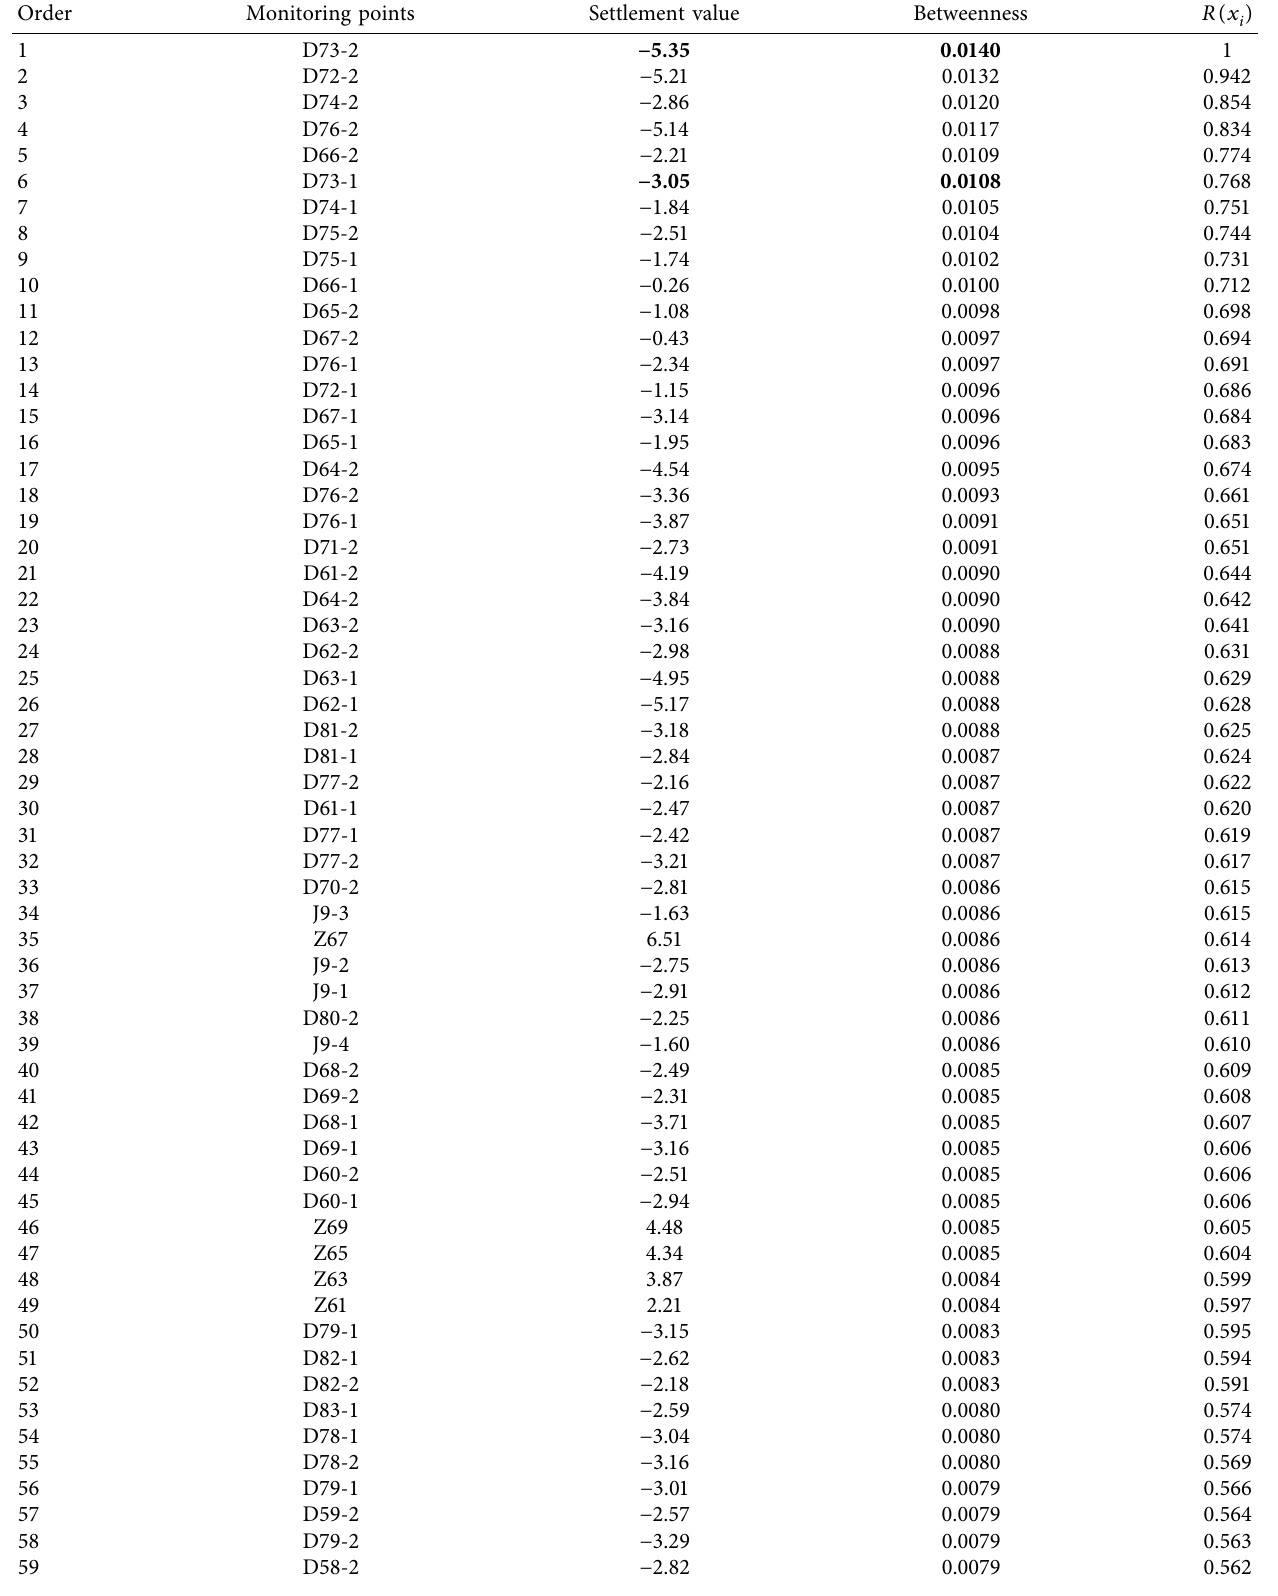
Table 7: Top 59 high-risk monitoring points based on betweenness